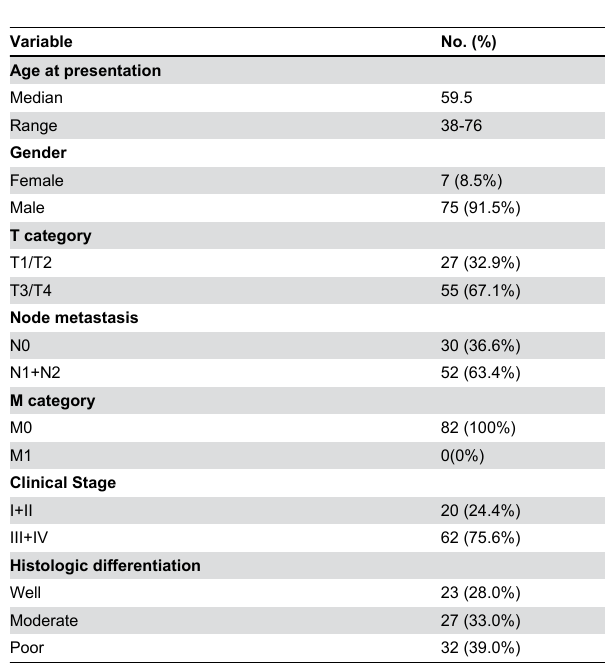
Table 1. Patient demographic and clinicopathologic characteristics